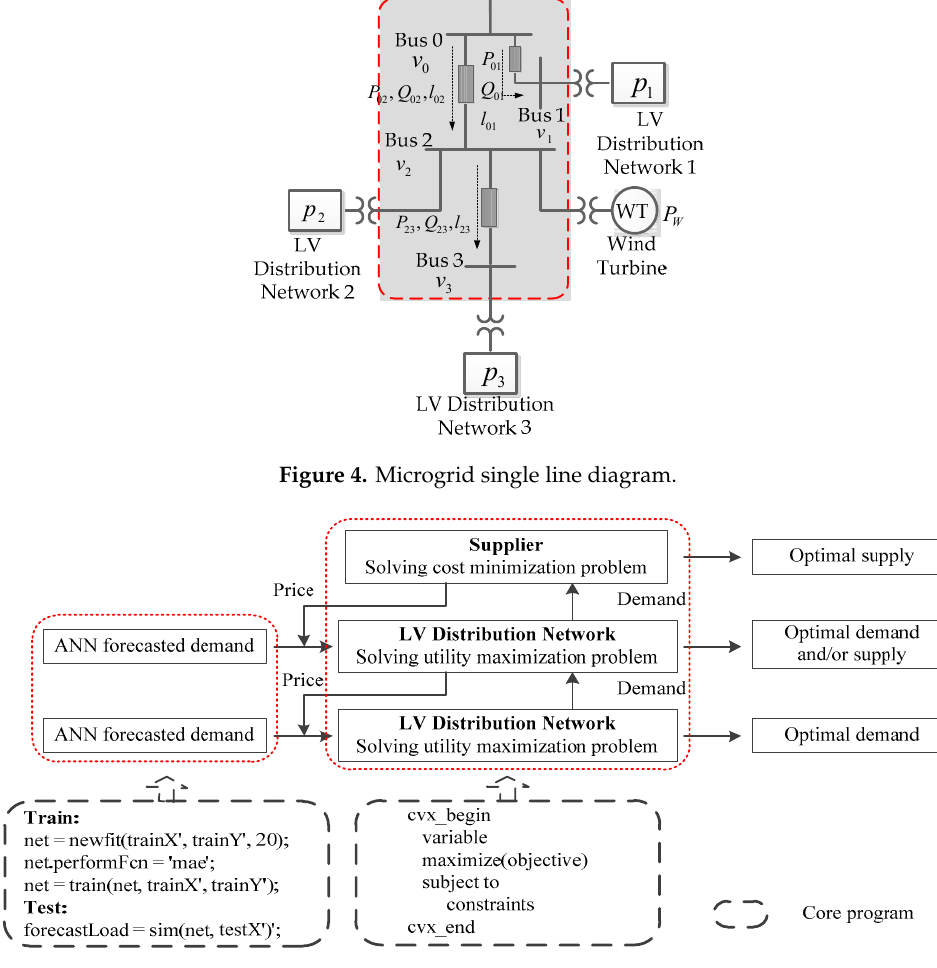
Figure 5. Process of evaluation.